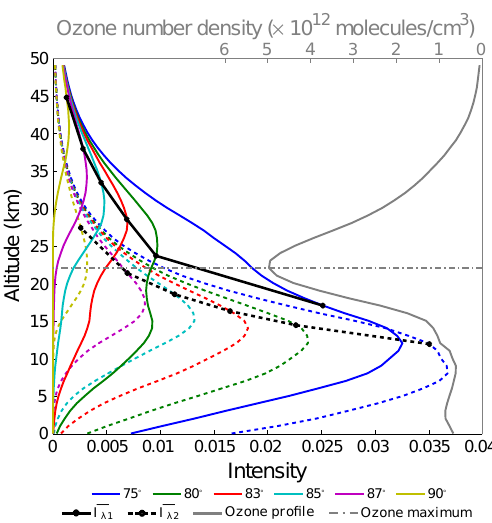
Figure 1. Zenith sky intensity contribution curves for C-pair wave- lengths at selected SZAs for 28 January 1994. Intensity values are arbitrary. The black curves show the weighted average height for each curve. Dashed lines correspond to the longer wavelength, while solid lines correspond to the shorter wavelength. An ozone profile with highlighted ozone maximum is also plotted for refer-